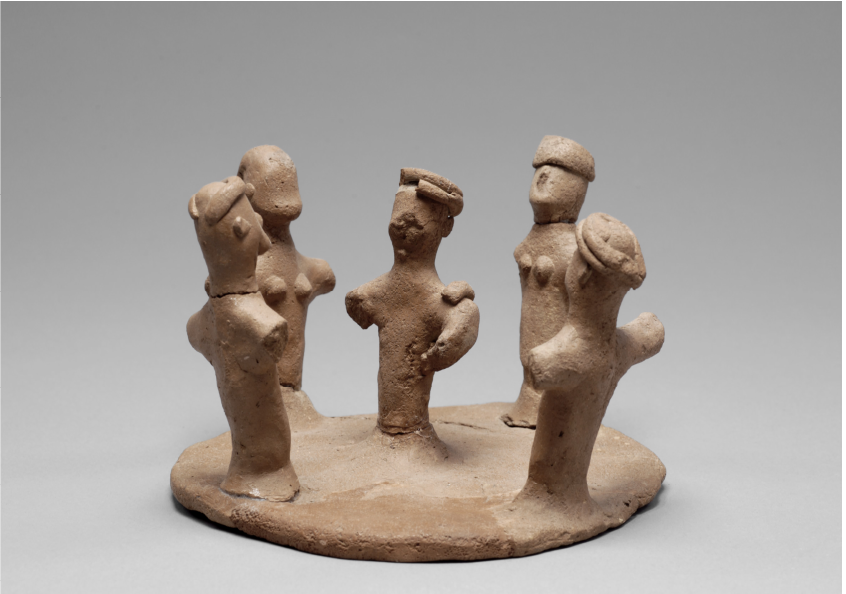
Figure 6. Terracotta group of ring dancers, A.I. 1693+2083 ©